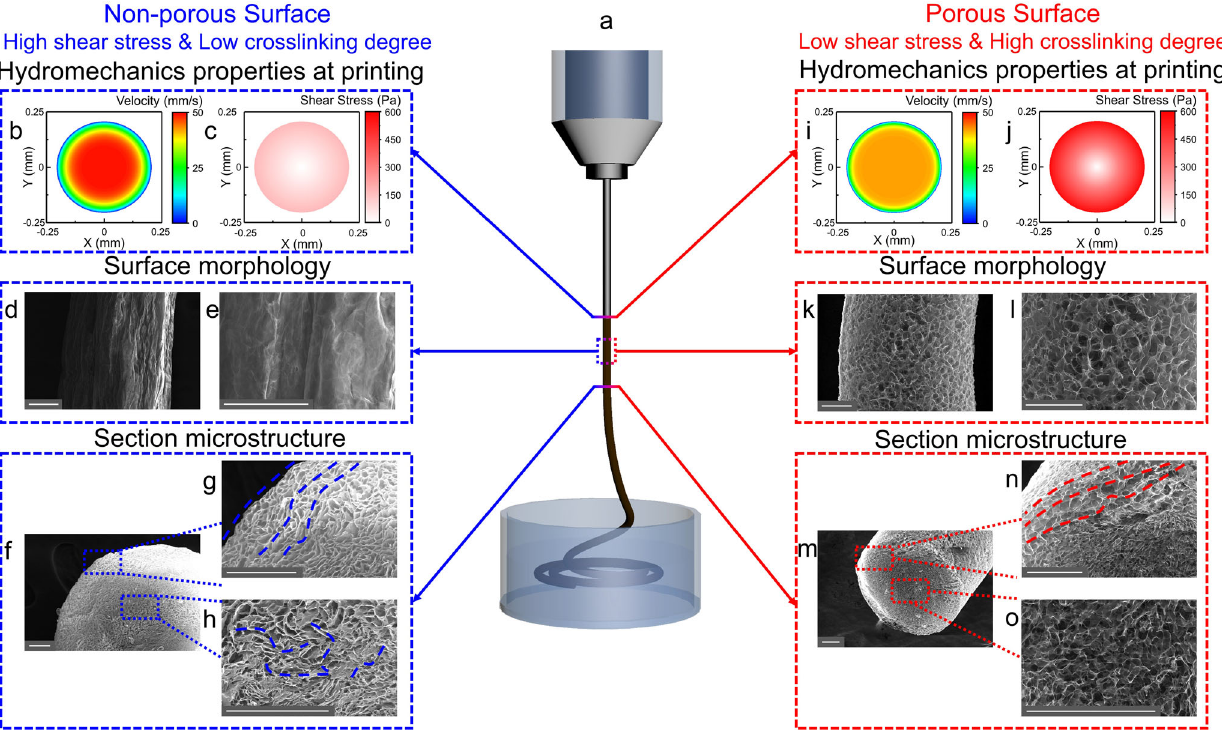
Fig. 1 Typical non-porous and porous morphology of printed GO aerogel fi laments. a Schematic demonstration of directly 3D printing GO ink into liquid nitrogen. b , c Distribution of ( b ) velocity and ( c ) shear stress at the nozzle in the printing of pure GO aerogel, printed at 300 μ L/ min with nozzle of 0.413 mm. d , e Surface SEM fi gures of as-printed pure GO aerogel. f – h Cross-sectional SEM fi gures of ( f ) section, ( g ) edge of section, and ( h ) centre of section of as-printed pure GO aerogel. i , j Distribution of ( i ) velocity and ( j ) shear stress at the nozzle in the printing of aerogel with ascorbic acid (160 mM), printed at 300 μ L min − 1 with nozzle of 0.413 mm. k , l Surface SEM fi gures of as-printed aerogel with 160 mM AA. m – o Cross-sectional SEM fi gures of the ( m ) section, ( n ) edge of section, and ( o ) centre of section of as-printed aerogel with 160 mM AA. Scale bars 100 μ m. Distribution of velocity and shear stress are obtained by CFD simulation (see